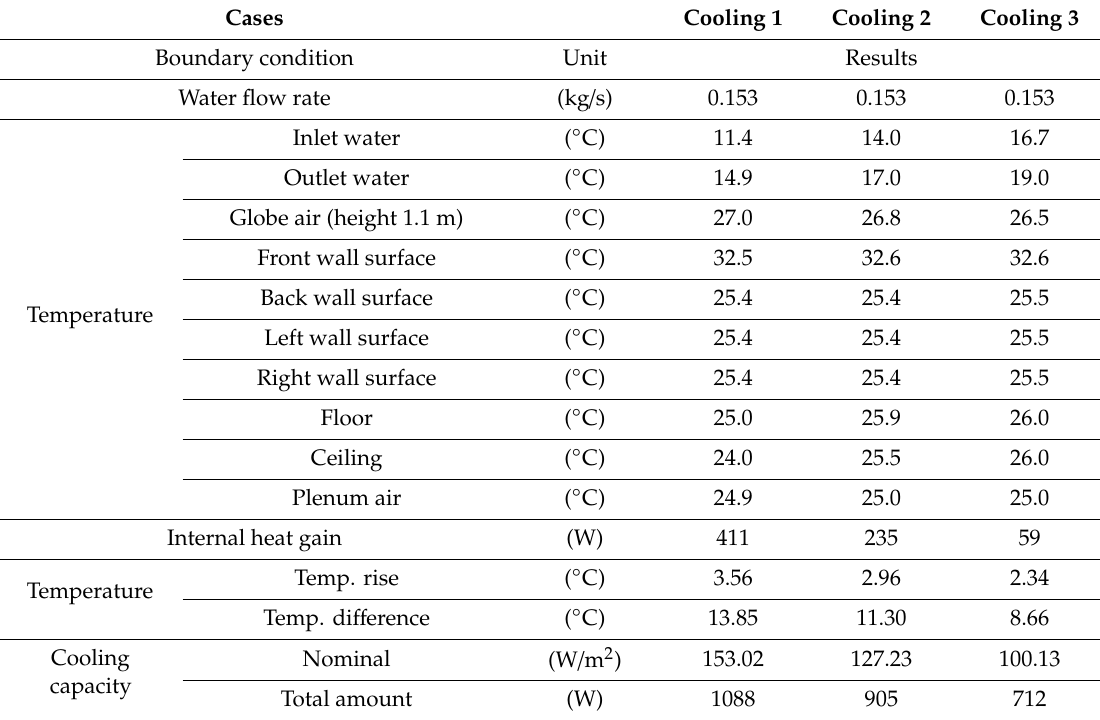
Table 17. Boundary condition for cooling capacity evaluation experiments.